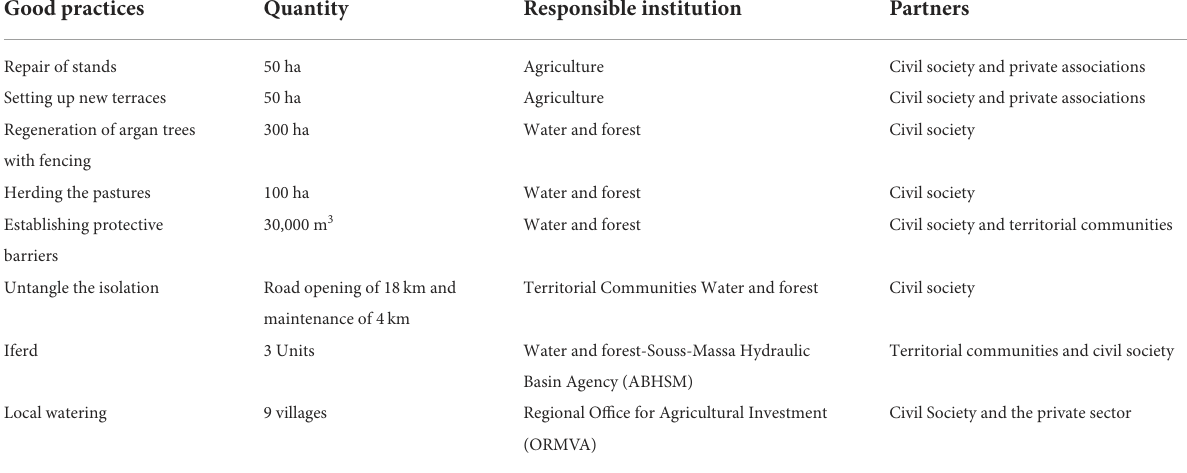
TABLE 4 Agreed activities under the Territorial Planning Pact in Amskroud